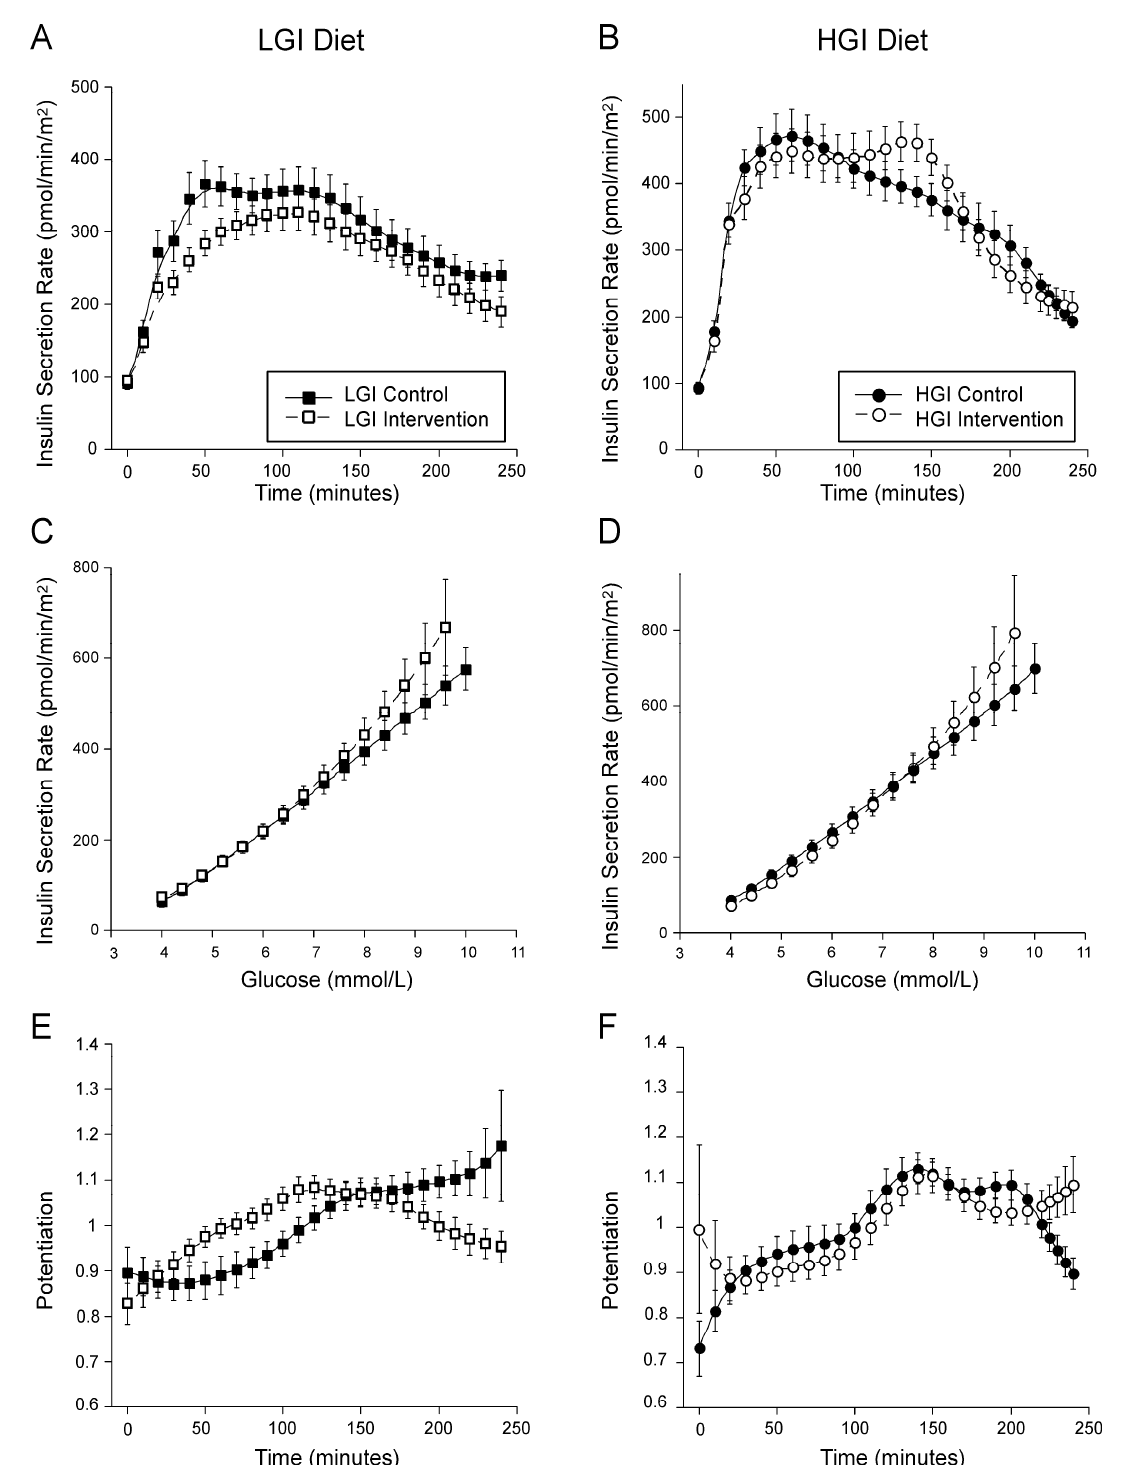
Figure 2. ISR vs. time ( A , B ), ISR vs. glucose dose response ( C , D ) and potentiation ( E , F ) from modeling of glucose and C-peptide concentrations during the MTT. The LGI diet is depicted by squares and the HGI diet by circles. The Control diet is denoted by solid symbols and a solid line and the intervention diet by open symbols and a dashed line. Mean ± SEM.